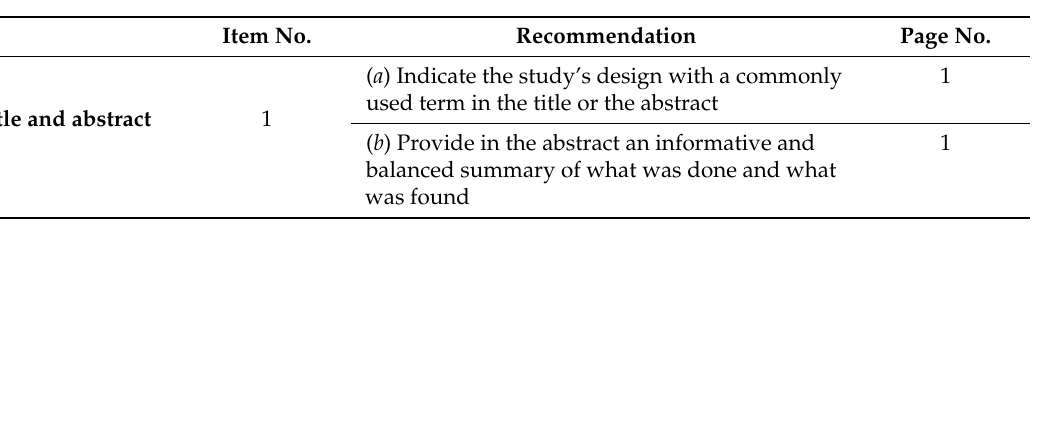
Table A1. STROBE